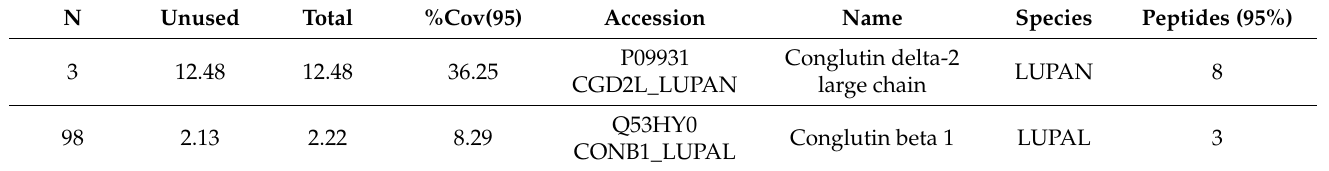
Table 1. Mass spectrometry analyses of L. albus deflamin